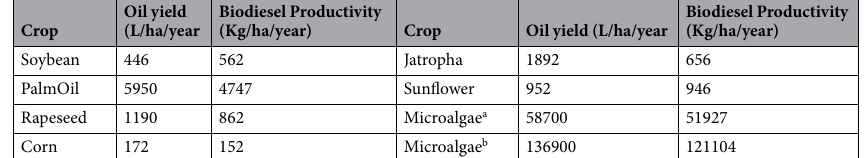
Table 1. Some biofuel feed stocks and their oil production 12, 13 . Algae a comprises 30% oil (/wt) in biomass and Algae b 70%.